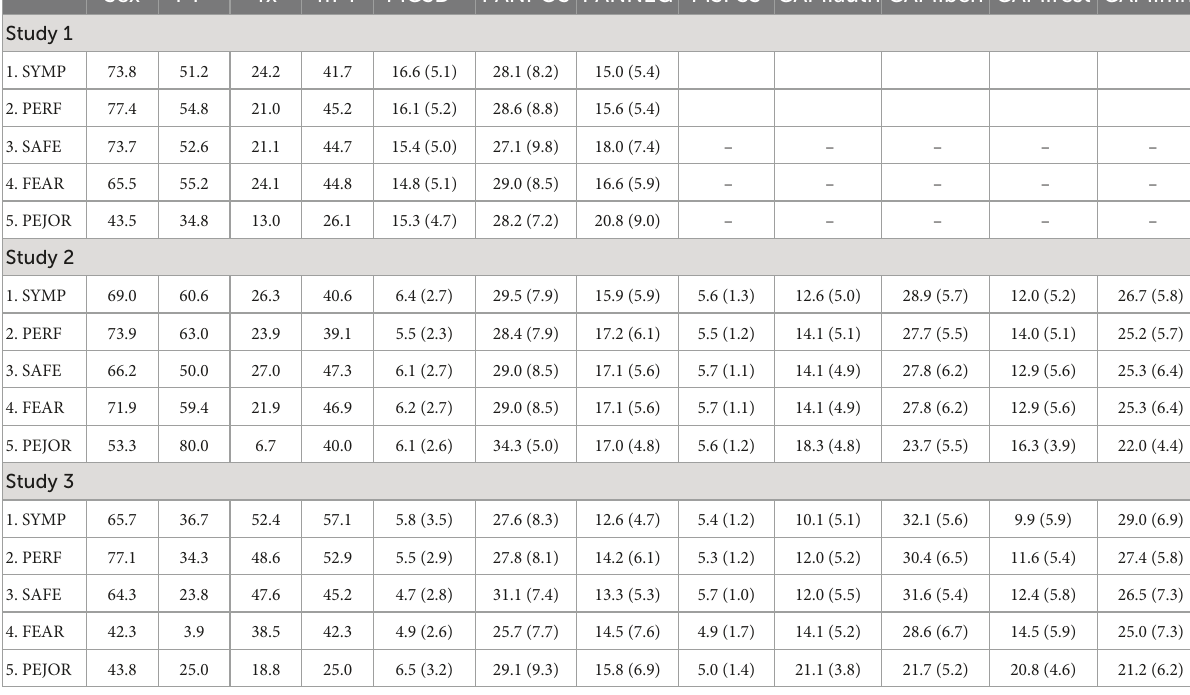
TABLE 3 Covariate scores for Study 1, Study 2, and Study